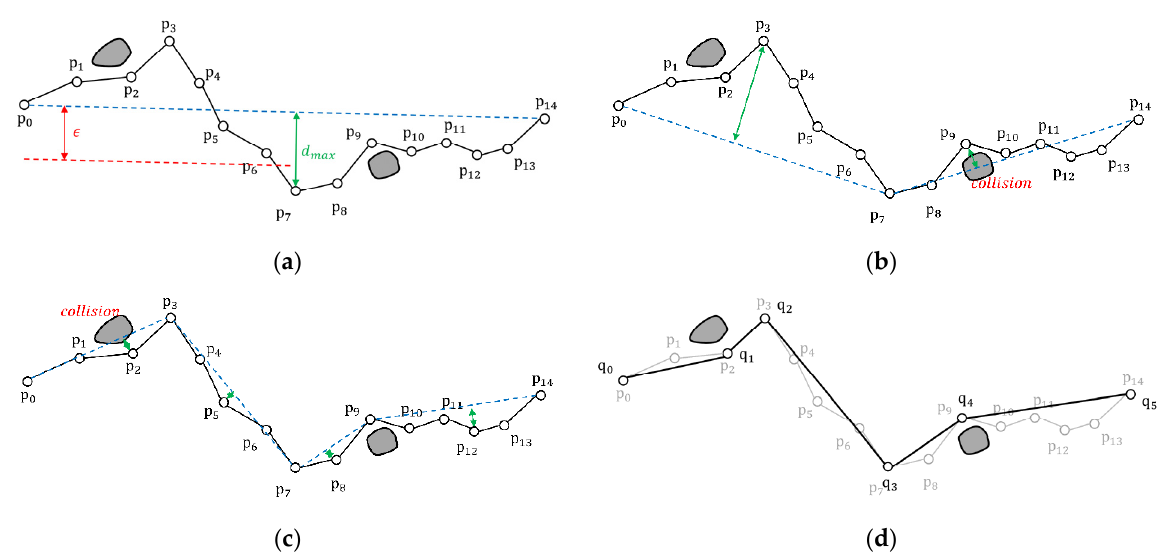
Figure 5. Route simplification using the ODP algorithm: ( a ) Check the original trajectory p 0 – p 14 ; ( b ) Check the subtrajectories 𝑝 (cid:2868) – 𝑝 (cid:2875) and 𝑝 (cid:2875) – 𝑝 (cid:2869)(cid:2872) ; ( c ) Check the subtrajectories 𝑝 (cid:2868) – 𝑝 (cid:2871) , 𝑝 (cid:2871) – 𝑝 (cid:2875) , 𝑝 (cid:2875) – 𝑝 (cid:2877) ,